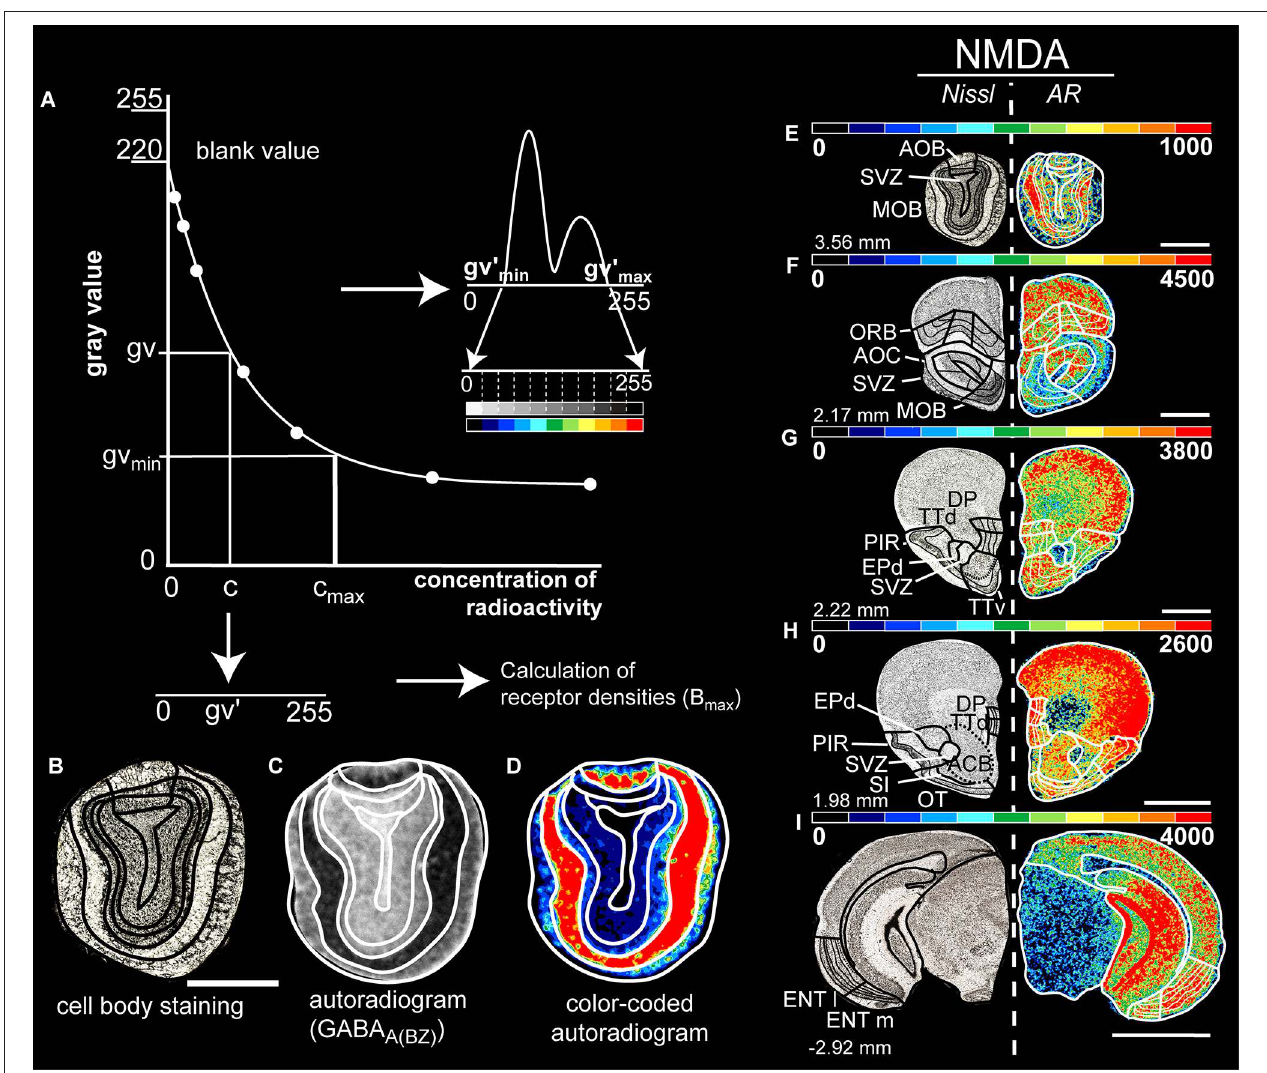
FIGURE 1 | (A) Calibration curve of the co-exposed isotope standards of known radioactivity for computation of the concentration of the bound ligand. A non-linear dependence of gray values and radioactivity concentration is provided. This allows the gray values of the autoradiograms to be converted pixel by pixel to the corresponding concentration of radioactivity. A gray level histogram of the transformed autoradiogram (C) was generated, followed by a linear contrast enhancement procedure. Here, the gray-scale histogram is transformed into a spectral arrangement of 11 colors to facilitate visualization of the density patterns on the autoradiograms (D) . A brain section of the same level with cell body staining (B) is used simultaneously to determine the boundaries. Figure (A) adapted by Zilles and Schleicher (1995) and Herold et al. (2014). ( E–I) Exemplary figure of the border identification in color-coded images that shows the distribution and density of glutamatergic NMDA receptors at different Bregma levels (left). The color scale of 11 equally distributed colors corresponds to the densities of receptors in fmol/mg protein. The color scale of each image has been optimized to provide the best visualization for different densities of the receptors. Therefore, the red end corresponds to the best visual fit for the investigated olfactory structure that is not necessarily the maximum density. Scale bars: (B–E), 1.3mm; (F–H), 1.5mm; (I), 2mm; MOB, main olfactory bulb; AOB, accessory olfactory bulb; AOC, anterior olfactory nucleus; TTd, taenia tecta, dorsal; TTv, taenia tecta, ventral; DP, dorsal peduncular cortex; PIR, piriform cortex; EPd, dorsal endopiriform nucleus; ENTl, entorhinal cortex, lateral; ENTm, entorhinal cortex, medial; ORB, orbitofrontal cortex; OT, olfactory tubercle; SVZ, subependymal zone; SI, substantia innominate.